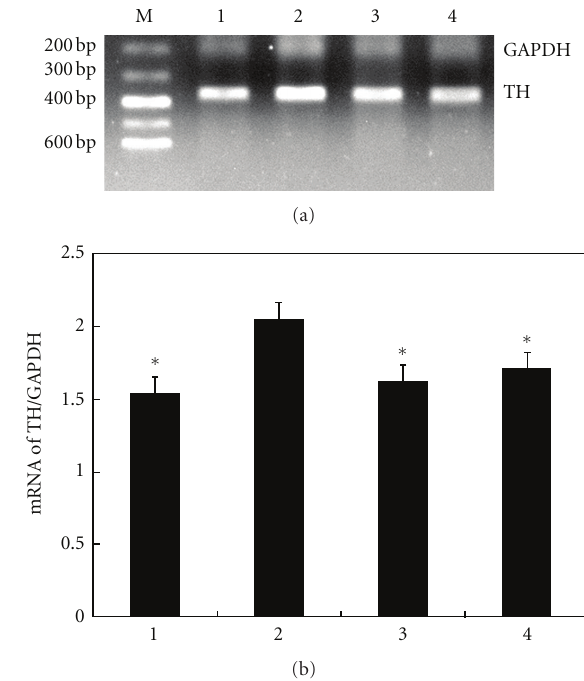
Figure 6: (a) RT-PCR products by electrophoresis of TH and GAPDH in the infarct border zone. (b) Ratio of TH band area GAPDH in the infarct border zone. M: marker; 1: sham-operated group; 2: control ischemic group; 3: preischemic treatment group; 4: delayed application group.